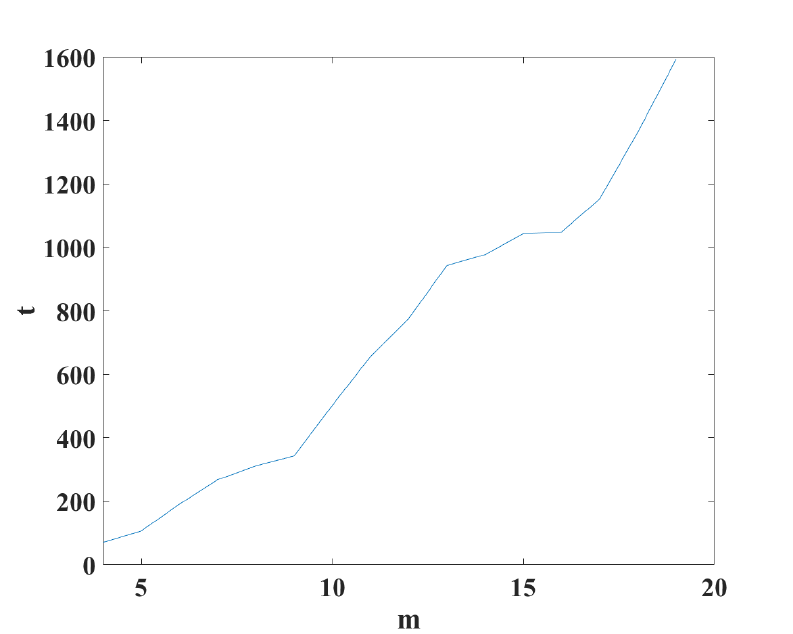
Figure 8. Times of particle settling for a fixed initial condition with respect to the space size m